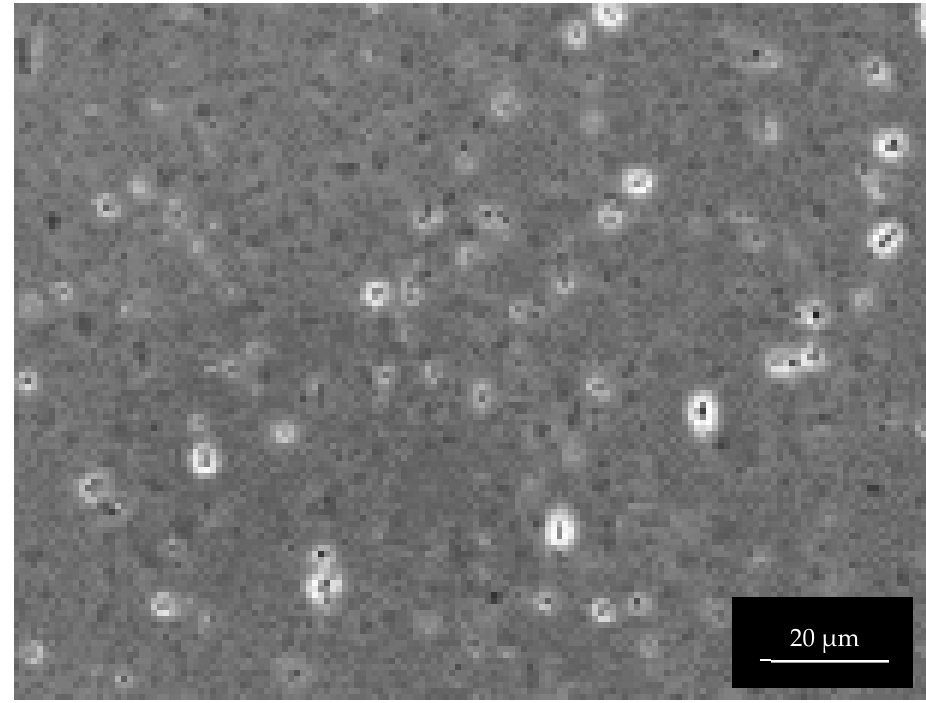
Figure A3. Surface of 3003-Al alloy with t a = 3600 s. Figure 5c was enlarged to 500%.